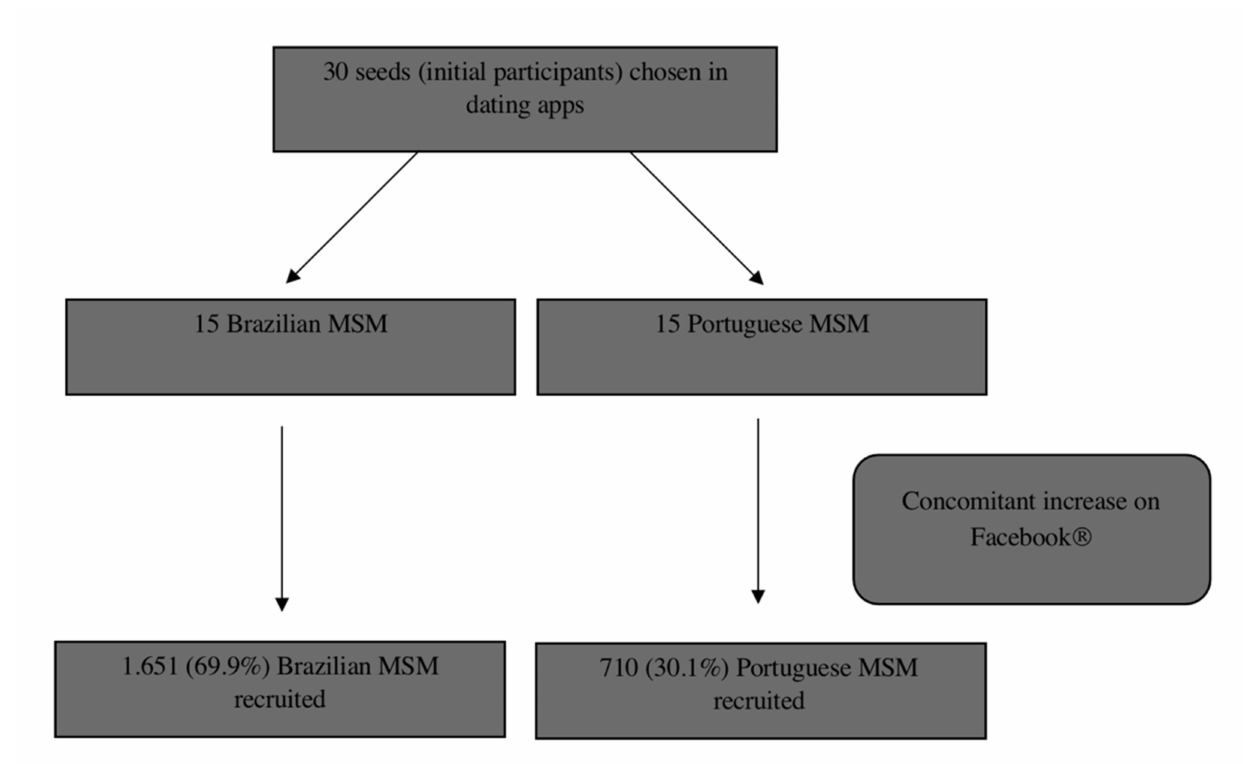
Figure 1. Flowchart for data